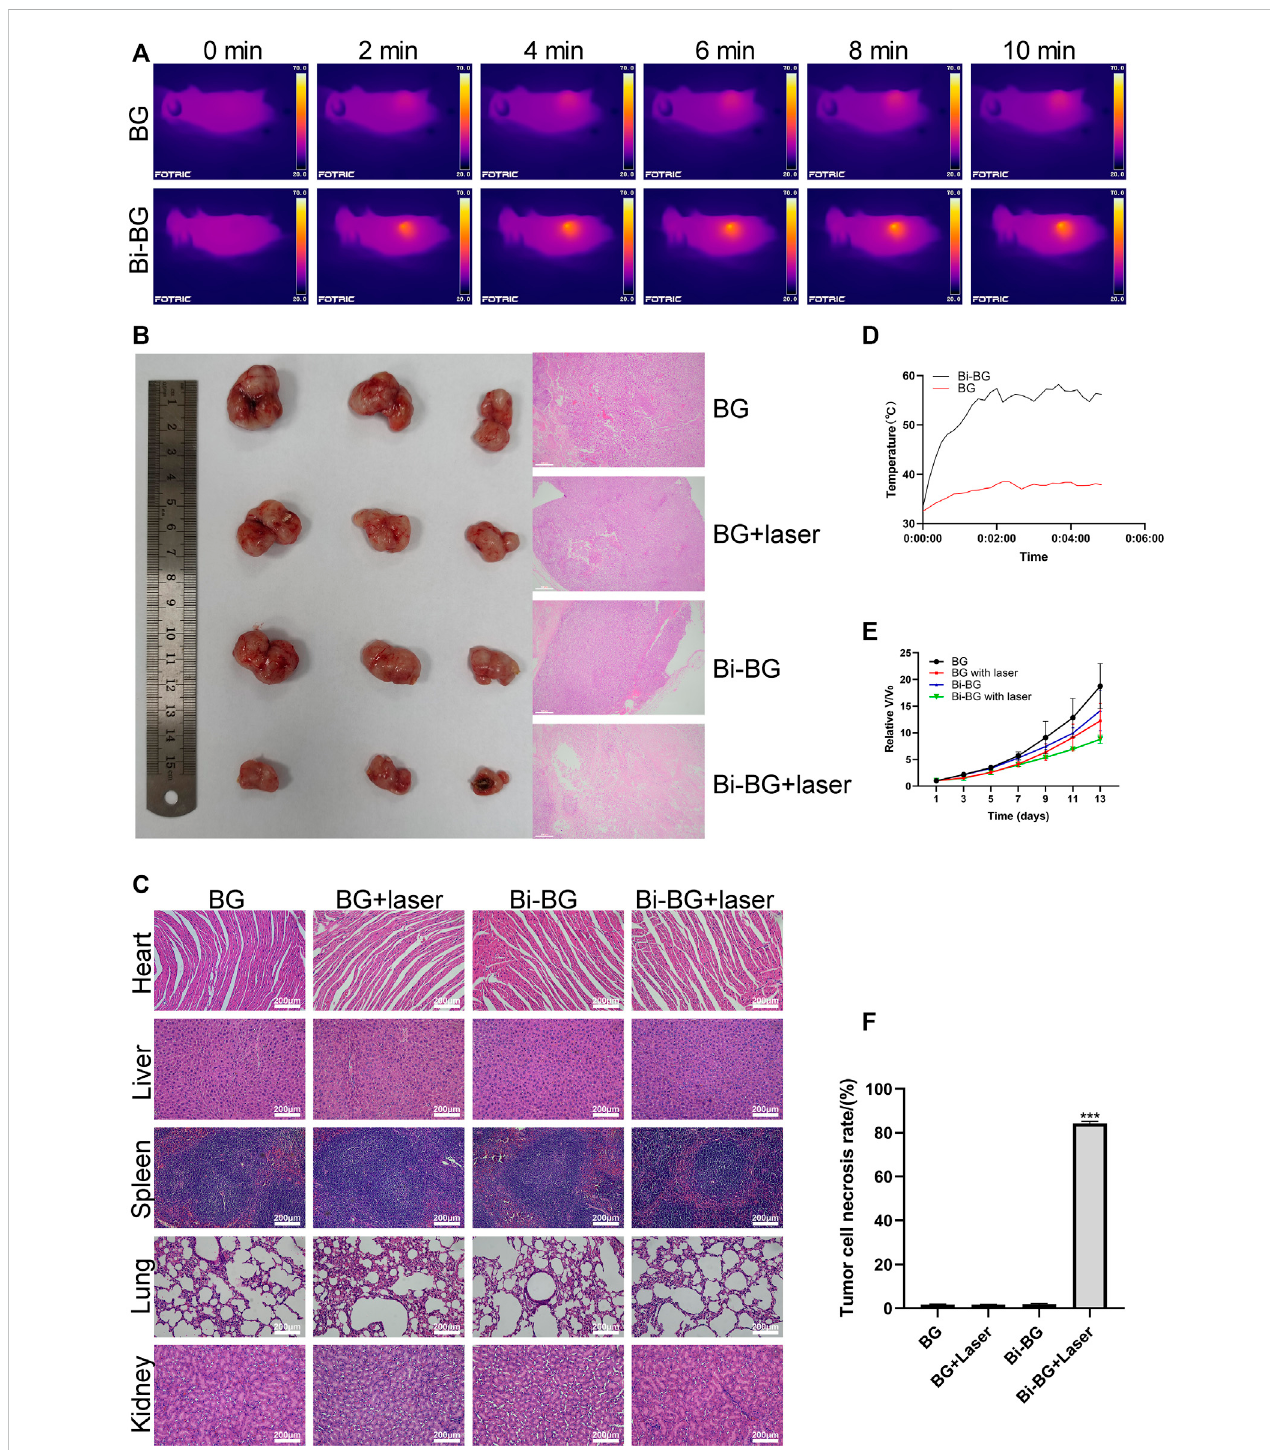
FIGURE 4 Invivo photothermalantitumoreffectofBi-BG scaffolds. (A) IRthermalimages, (B) opticalandH&Estainingimages oftumorinfourgroupsatday13, (C) H&E staining images of major organs from the four groups (scale bar: 100 μ m). (D) Heating curveof BG and Bi-BG scaffolds innude mice under 808 nm laser irradiation, (E) relative tumor volume change with increasing days of the groups, and (F) the tumor cell necrosis rate (TCNR) of four